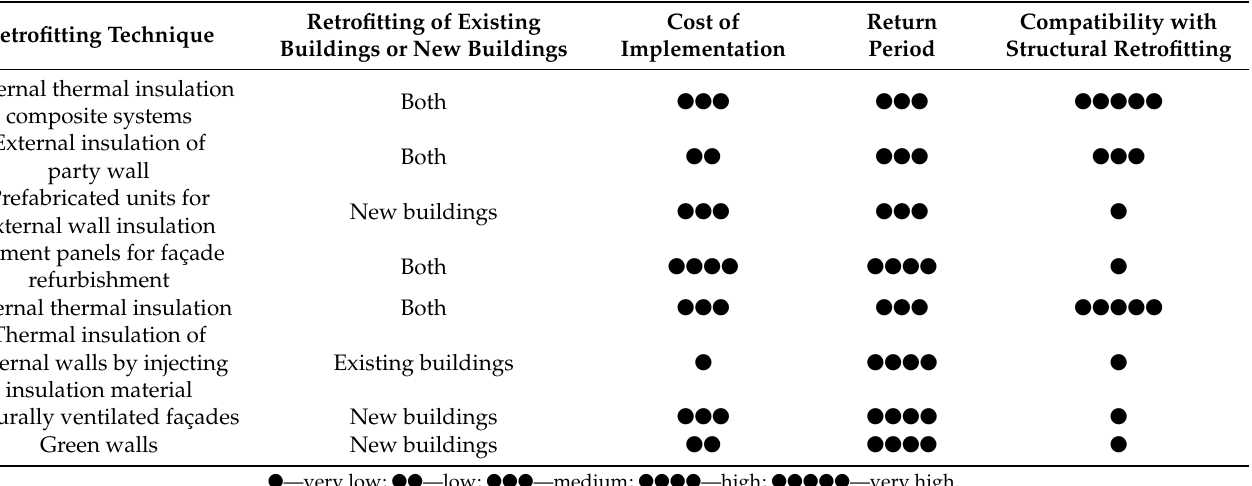
Table 2. Summary of the available energy retrofitting techniques for